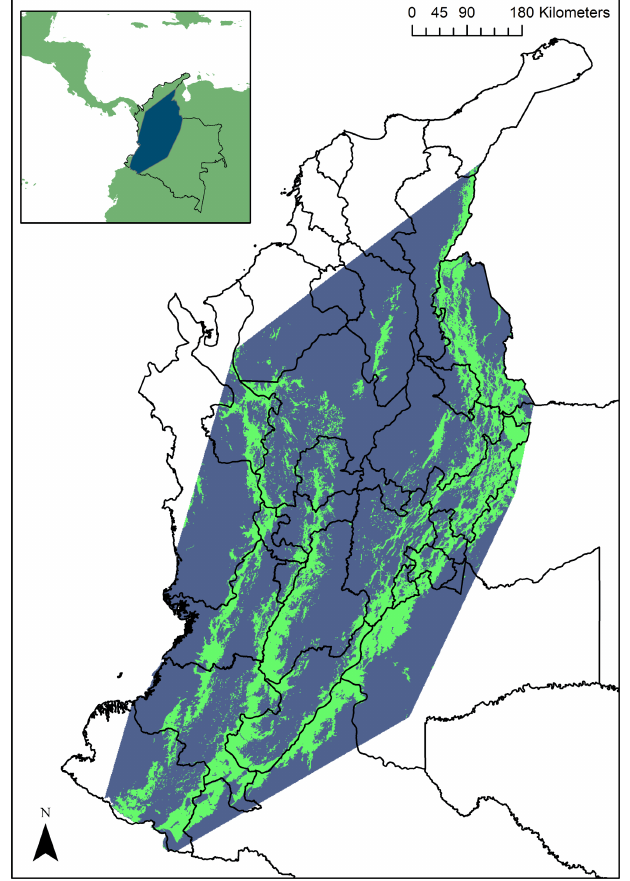
Fig. 2 . This connectivity model for Andean bears in Colombia was constructed with circuit theory and was the basis for the ecological network in this analysis. Areas in green are those that were predicted by the model to be most important for Andean bear ( Tremarctos ornatus ) connectivity within the delineated study area (blue). Jurisdictions of the autonomous regional corporations ( corporaciones autonomas regionales [CARs]) are